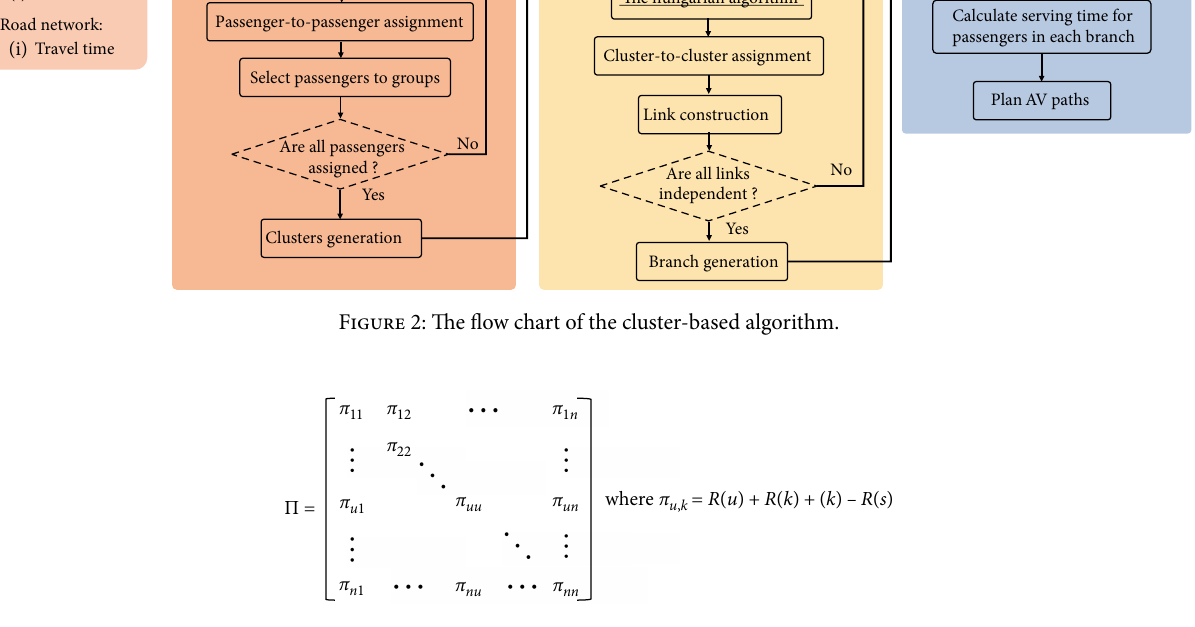
Figure 3: The relationship matrix of